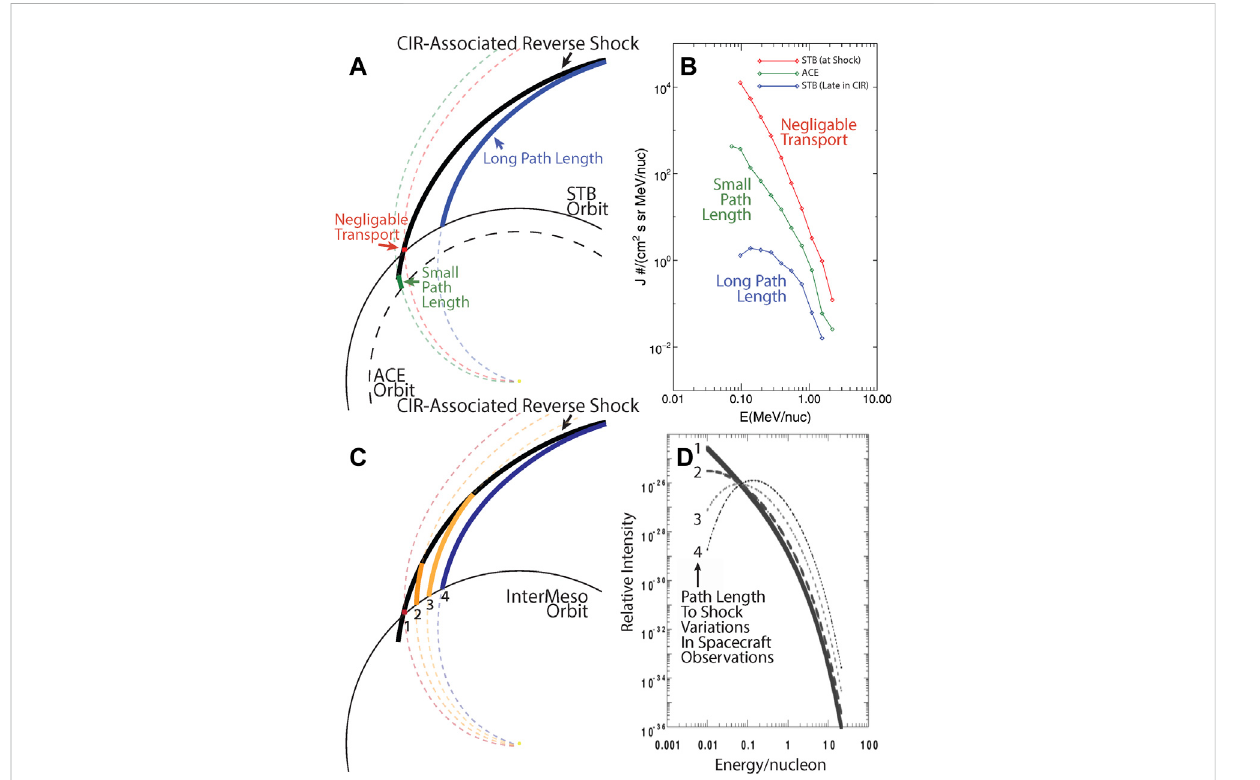
FIGURE 8 (A) Cartoon of the observation locations relative to a CIR-associated reverse shock inferred from (B) energetic particle spectra (adapted from Zhao et al., 2016). (C) Distributed observations at mesoscale separations are needed to (D) constrain the transport effect on particle spectra without ambiguities from temporal evolution (adapted from Mason et al.,